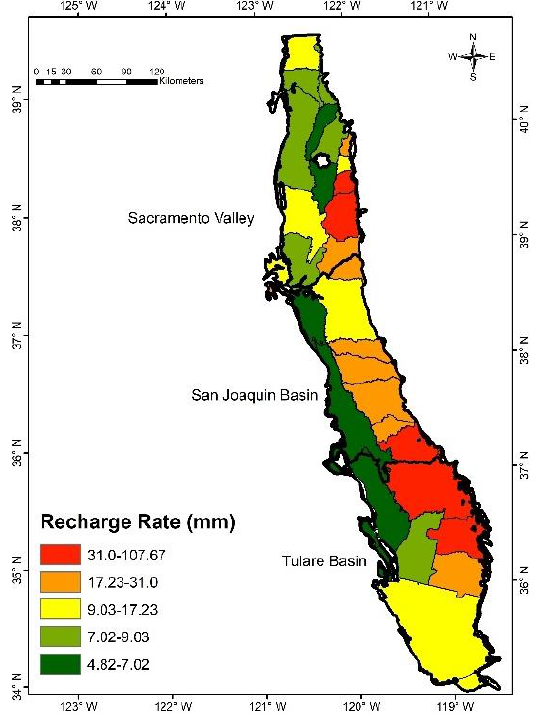
Figure 5. Recharge rate in Central Valley